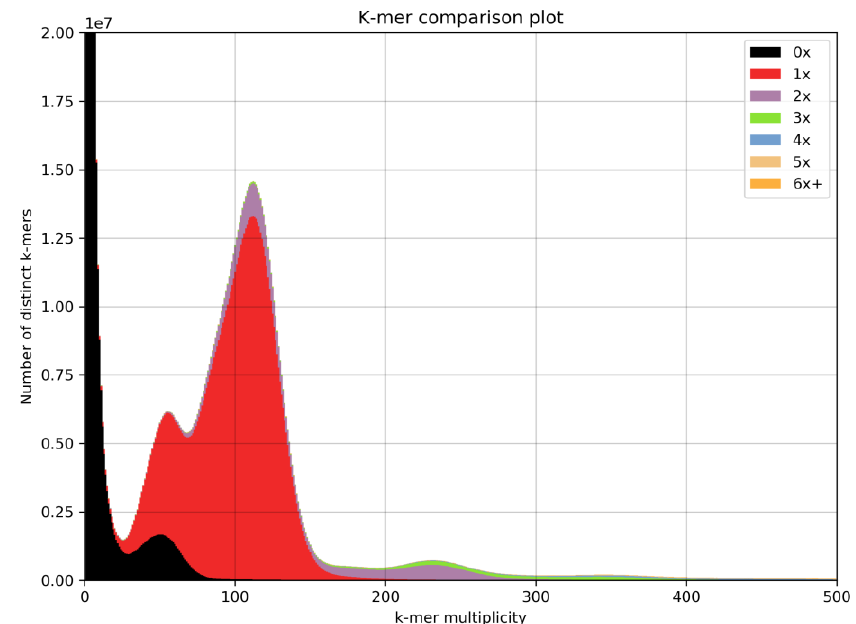
Figure 4. A k-mer comparison plot for the genome of Alpinia nigra (k = 27). The colour of the plots indicates the number of times k-mers from the reads appear in the assembly. Black region indicates the k-mers missing from the assembly, red indicates k-mers that are present once in the assembly, purple twice, and so on. Table 1. Assembly metrics for the Alpinia nigra genome assembled using DISCOVAR de novo . The assembly metrics were estimated using QUAST v5.0.2 [54] and the completeness of the assembly was estimated with BUSCO v3.0.2 using the embryophyta_odb10 BUSCO set. Total Length ( ≥ 0